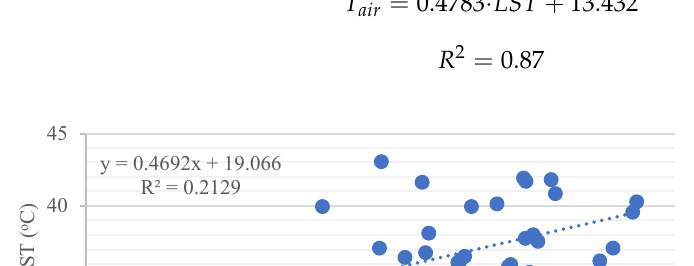
Figure 4. Comparison of average surface temperature between city and suburbs over the day.